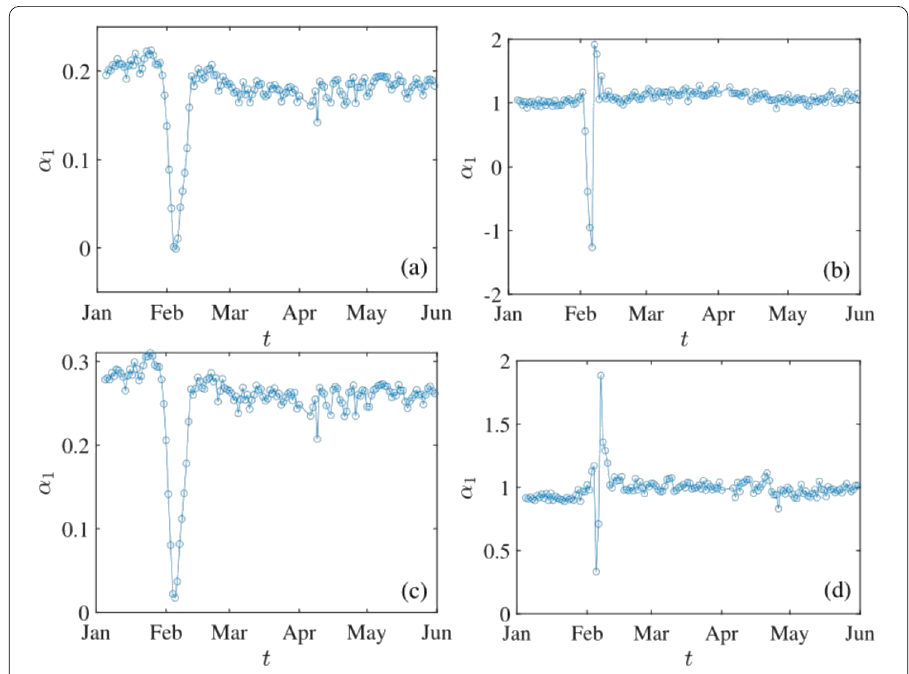
Figure 6 Evolution of the exponents α 1 of daily directed and undirected freight highway transportation networks. ( a ) Scatter data of F ij with respect to P i P j / d 2 ij for the directed network. ( b ) Binning data of F ij with respect to P i P j / d 2 ij for the directed network. ( c ) Scatter data of W ij with respect to P i P j / d 2 ij for the undirected network. ( d ) Binning data of W ij with respect to P i P j / d 2 ij for the undirected